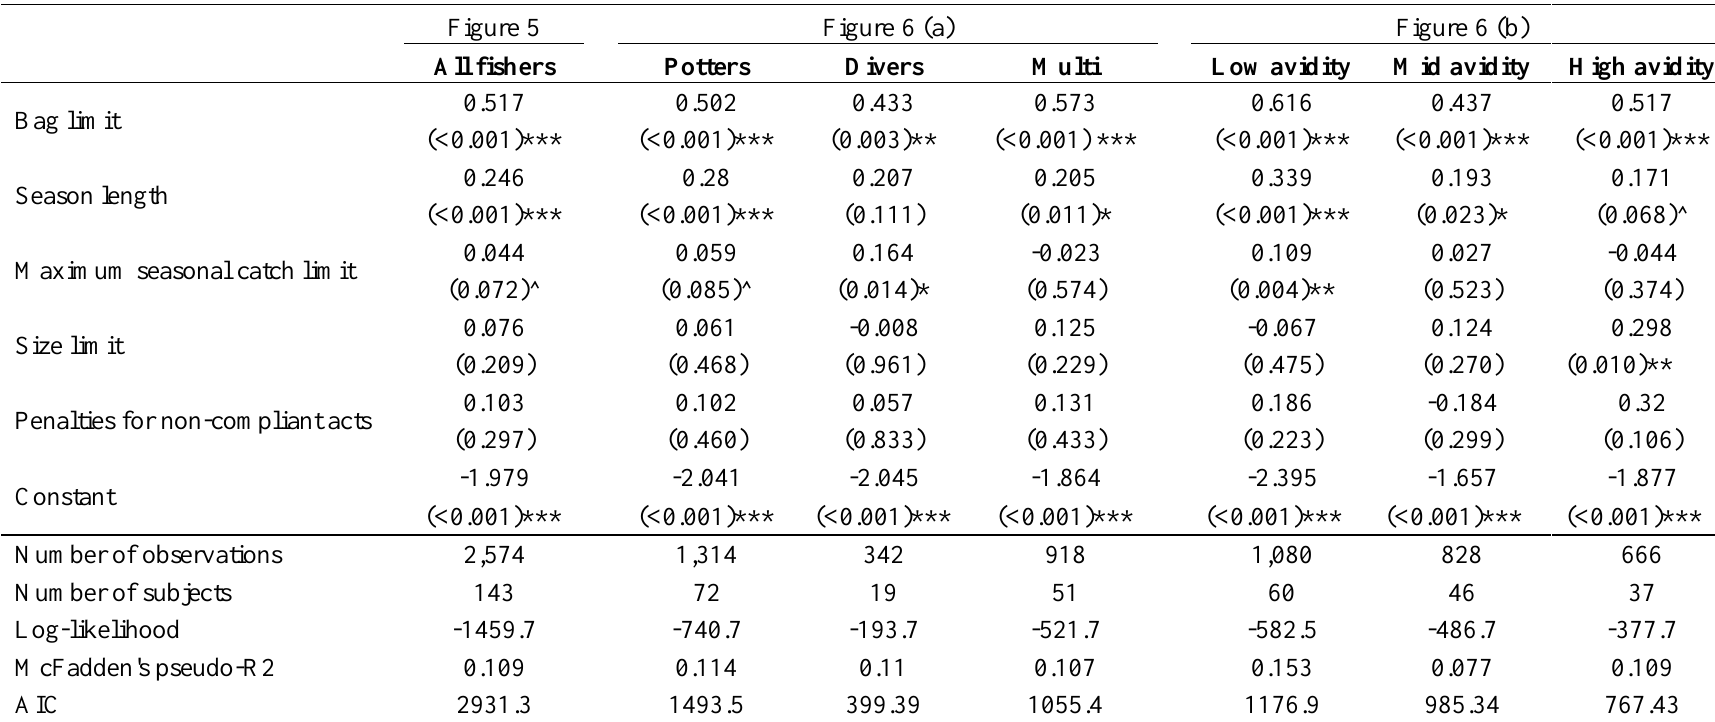
Table A.1. Conditional logit on discrete choice experiment data for different fishing methods and fishing avidity